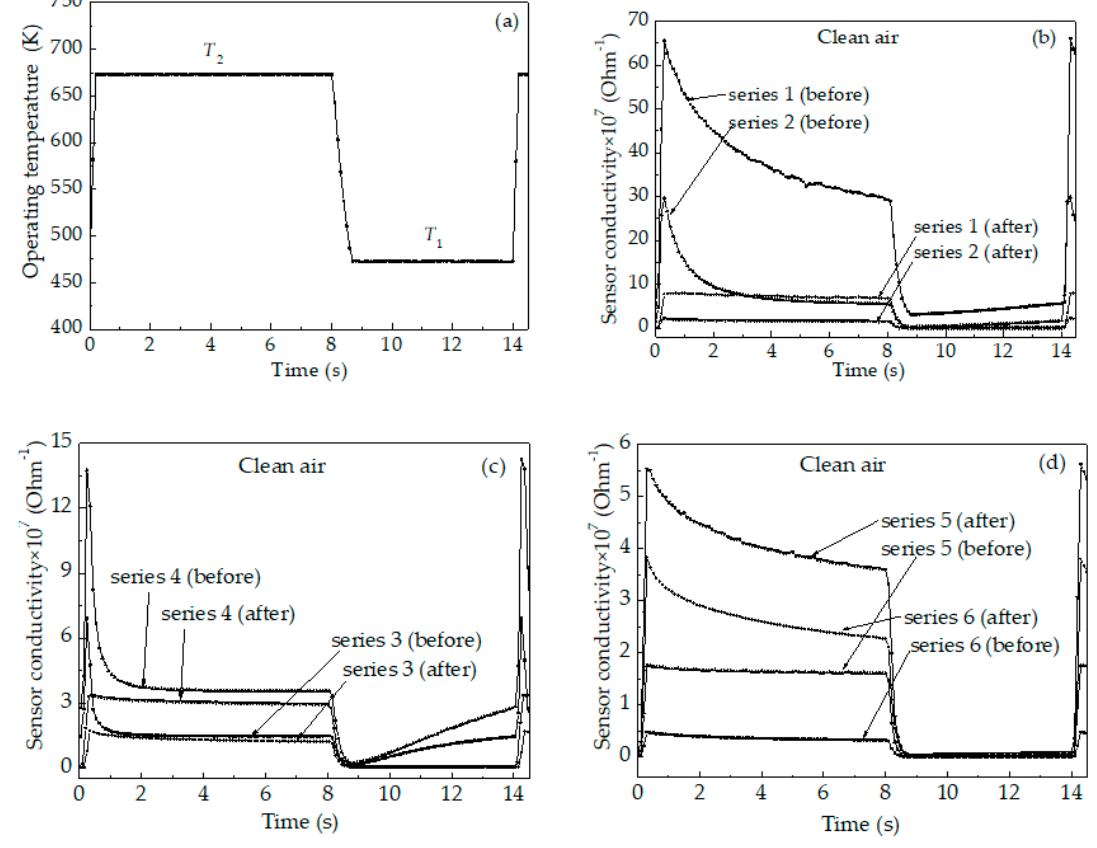
Figure 12. ( a ) The changing of operation temperature in thermo-cyclic mode and ( b – d ) the conductivity-time profiles in clean air in this mode before and after the tests of the sensors with the various